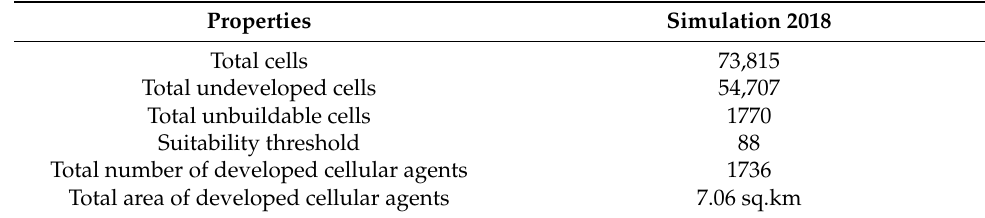
Table 6. Statistical results of simulation map of 2018.